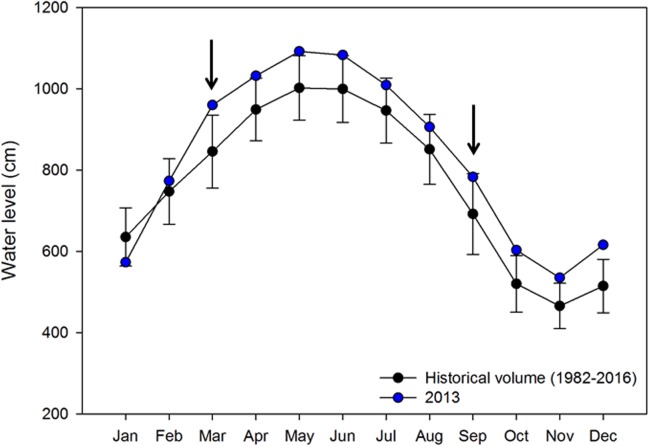
Mean water level and standard deviation in the Lago Grande do Curuai system.Black points indicate historical water level. Blue points indicate water level from the sampling year. Arrows indicate sampling dates. Data source: Agência Nacional de Águas, Hidroweb (data from 1982 to 2016).